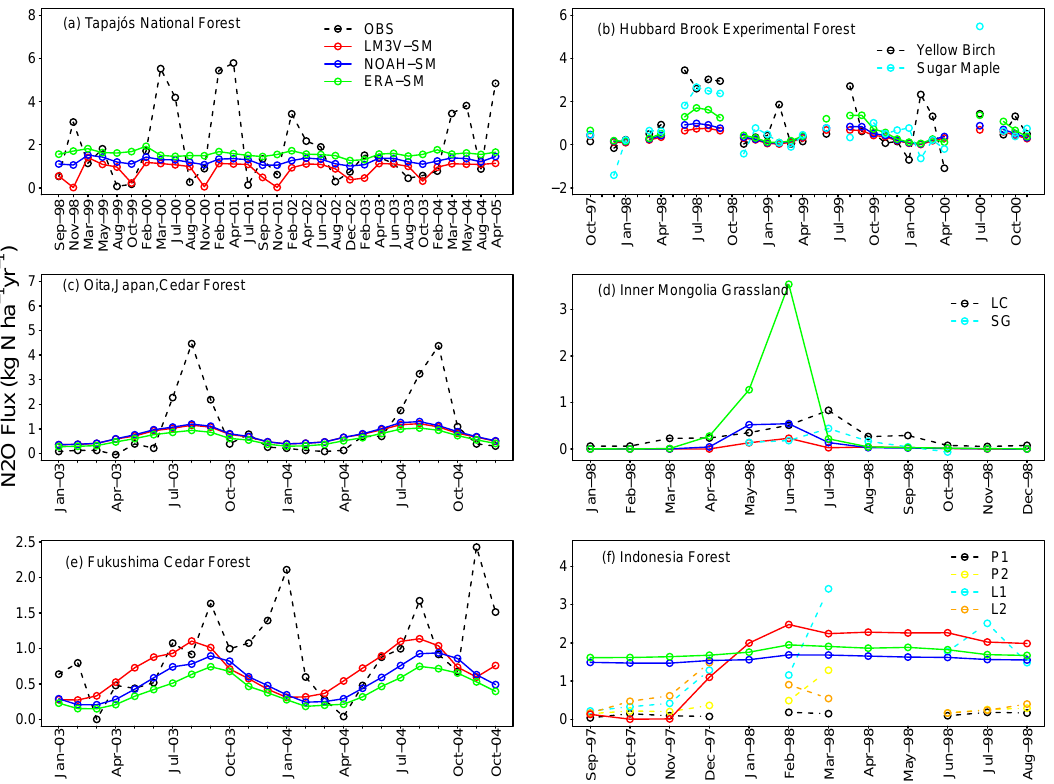
Figure 5. Observed vs. simulated monthly N 2 O emissions at (a) , the Tapajós National Forest in east-central Amazonia (3 ◦ S, 55 ◦ W), taken from Davidson et al. (2008); (b) the Hubbard Brook Experimental Forest in New Hampshire, USA (44 ◦ N, 72 ◦ W), taken from Groffman et al. (2006); (c) a cedar forest at Oita, Japan (33 ◦ N, 131 ◦ E), taken from Morishita et al. (2007); (d) the Leymus chinensis (LC) and Stipa grandis (SG) steppe in Inner Mongolia, China (44 ◦ N, 117 ◦ E), taken from Xu-Ri et al. (2003); (e) a cedar forest in Fukushima, Japan (37 ◦ N, 140 ◦ E), taken from Morishita et al. (2007); and (f) the primary (P1 and P2) and secondary (L1 and L2) forests located at the Pasir Mayang Research Site, Indonesia, taken from Ishizuka et al. (2002; 1 ◦ S, 102 ◦ E). Shown are modelled results from three WFPS schemes (LM3V-SM, NOAH-SM and ERA-SM) the same as in Fig.